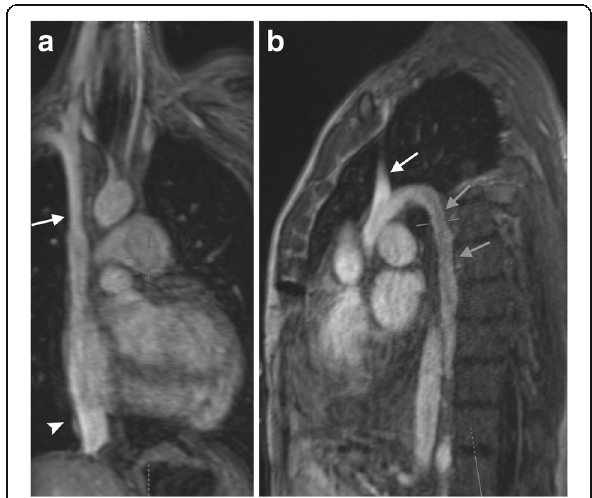
Fig. 4 MRI venous imaging. Coronal ( a ) and sagittal ( b ) images of the thoracic venous anatomy in the late arteriovenous phase of imaging of a MRI scan. The SVC (white arrow), IVC (arrowhead), and azygos vein (gray arrows) are labeled